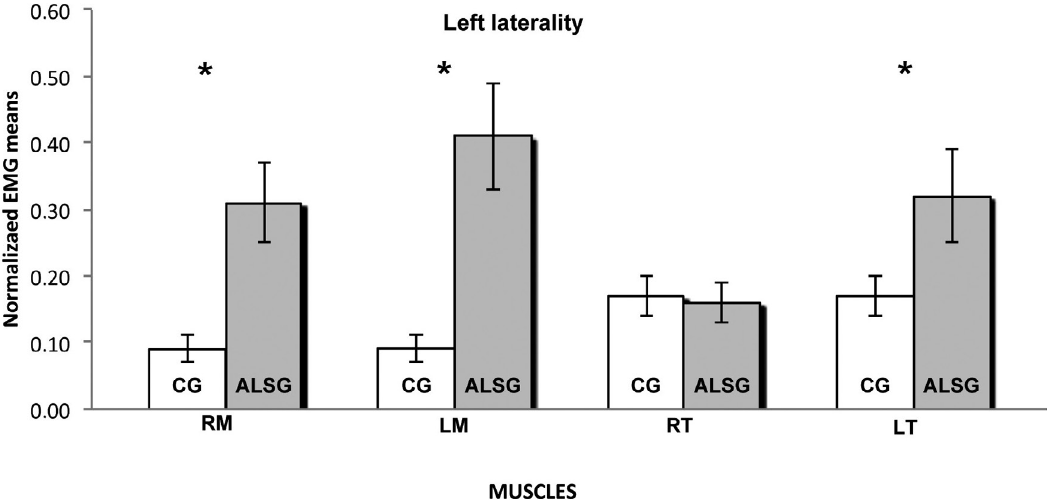
Figure 3- Normalized electromyography data of masseter (RM: right masseter; LM: left masseter) and temporalis (RT: right temporal; LT: left temporal) muscles for CG and ALSG in the left laterality. *statistically significant difference (p≤0.05)